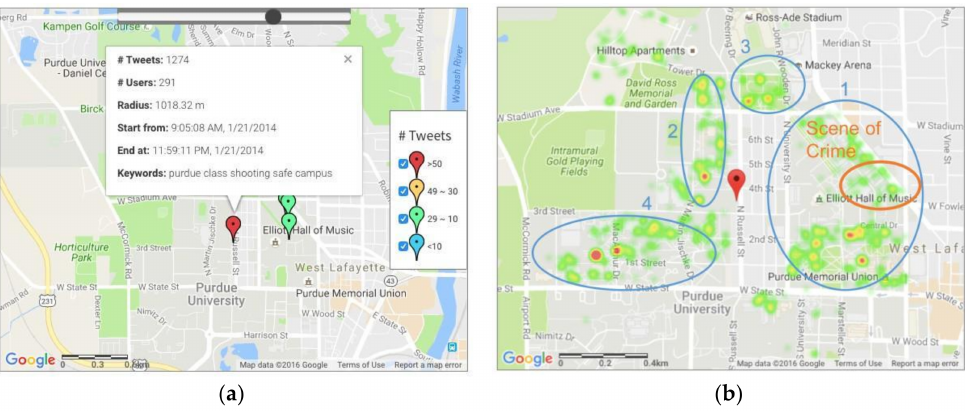
Figure 5. Spatial-temporal clustering results for the tweets in West Lafayette on 21 January 2014 when the gunshot occurred: ( a ) cluster centers and the most significant cluster; and ( b ) distribution of the tweets in the most significant cluster. ( d 1 = 200 m, d 2 = 60 min, minPts =